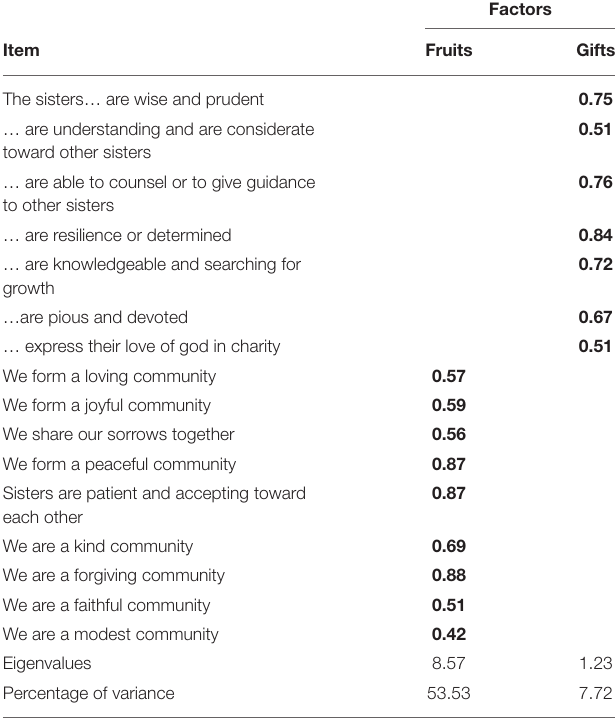
Extraction Method: Principal Component Analysis. Rotation Method: Oblimin with Kaiser Normalization. Only loadings over 0.40 appear in